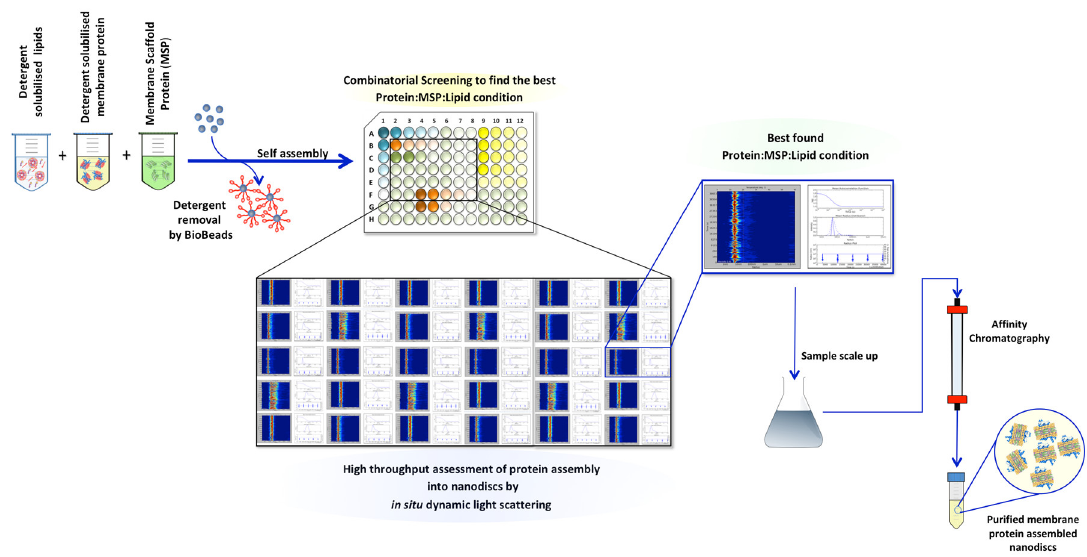
Figure 5. Schematic representation of the membrane protein assembly into nanodiscs process using in situ DLS as a high-throughput analytical tool to probe best protein:MSP:lipid condition.